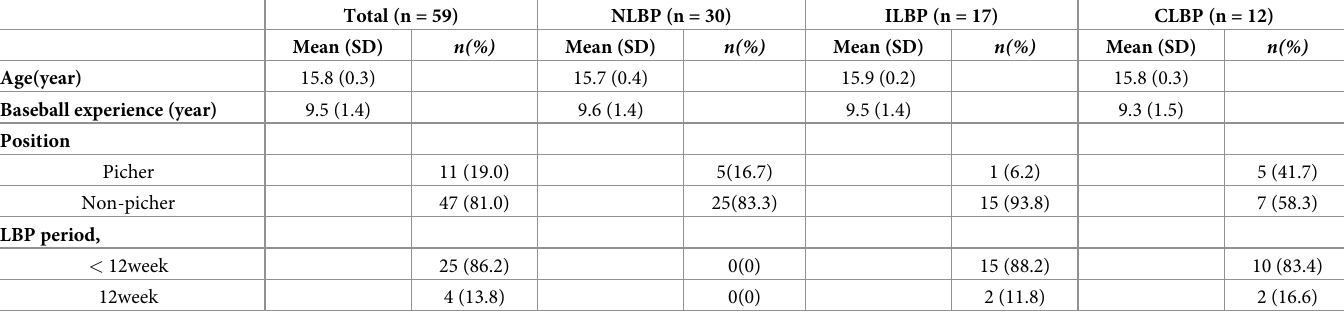
Table 1. Baseline characteristics of the participants.